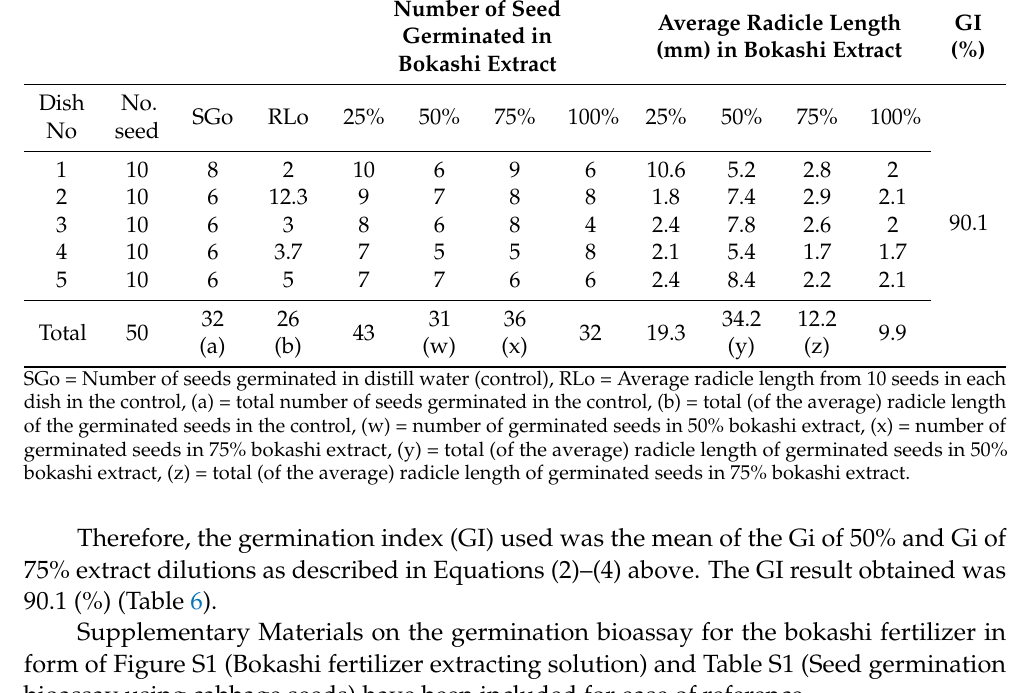
Number of Seed Germinated in Bokashi